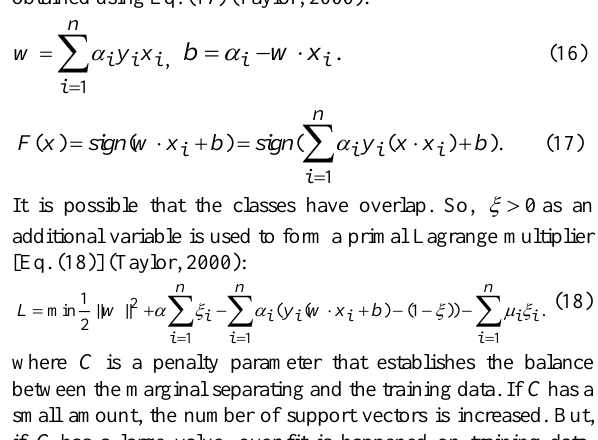
of each plane using linear polynomial curve. The goal of this